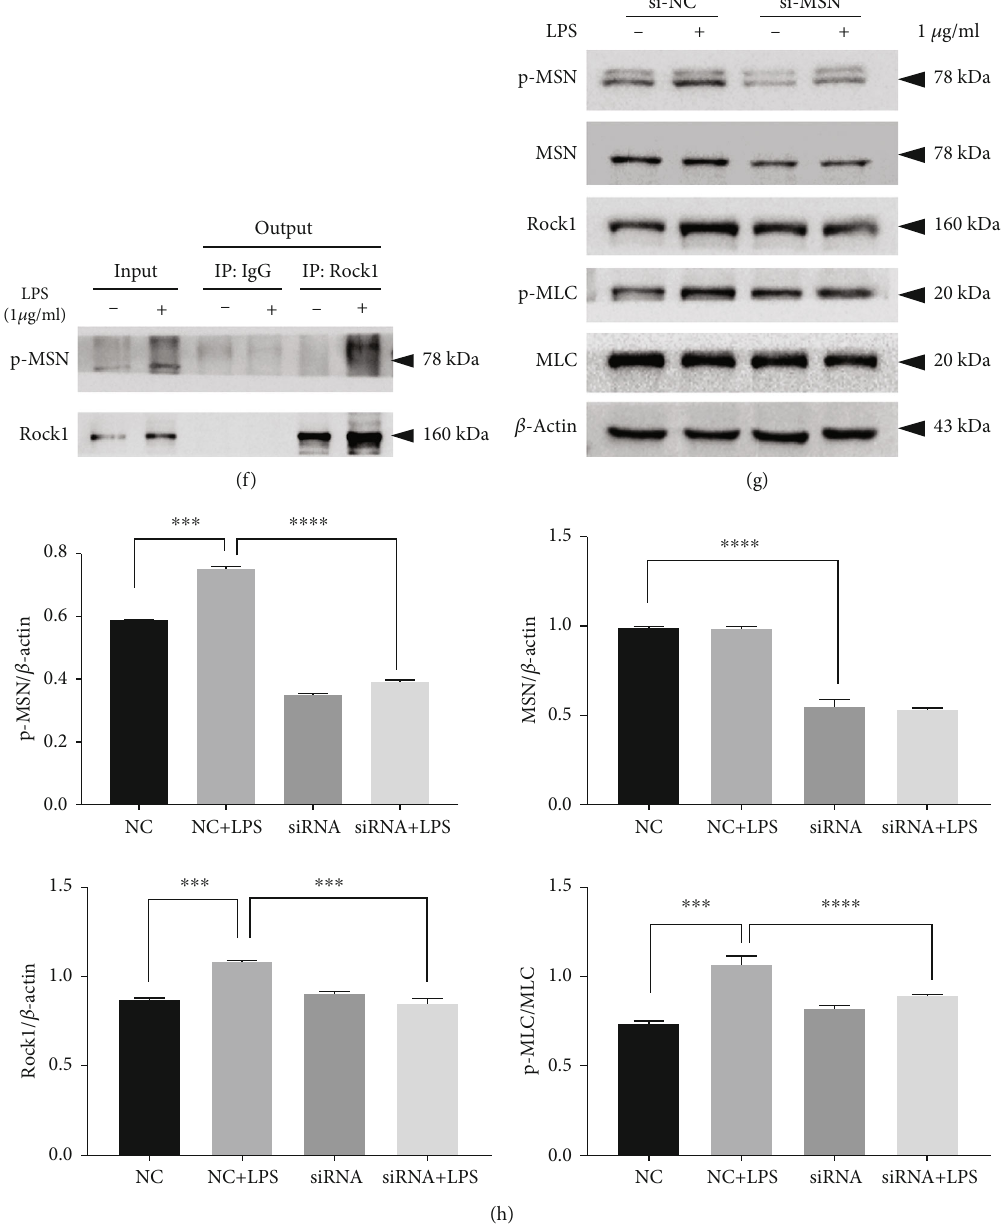
Figure 5: MSN inhibition reversed LPS-induced vascular hyperpermeability and recovered the MLC expression in HMECs via regulating the Rock1 activity.(a) RT-qPCR and (b) Western Blotting analyses of the e ffi cacy of MSN silencing in HMECs, and the semiquanti fi cation for MSN silencing was shown in (c). (d) MSN silencing abrogated the LPS-induced vascular hyperpermeability in monolayer HMECs, determined by the FITC-dextran-based barrier integrity assay. (e) Protein interaction analysis showed that MSN was closely related to the RhoA/Rock pathway. (f) Coimmunoprecipitation analyses of the interaction between p-MSN and Rock1 in HMECs treated with or without LPS (24 h). (g) MSN silencing mitigated the LPS-increased MSN and MLC phosphorylation and Rock1 expression in HMECs, and the semiquanti fi cation for WB was shown in (h). ∗ p < 0 : 05 , ∗∗ p < 0 : 01 , and ∗∗∗ p < 0 : 001